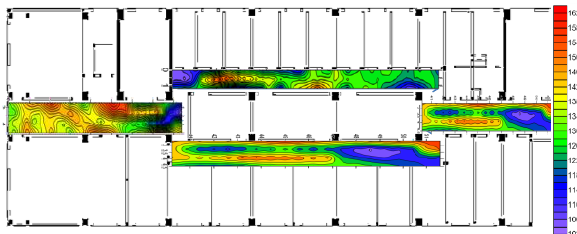
Figure 4. Construction of geomagnetic reference